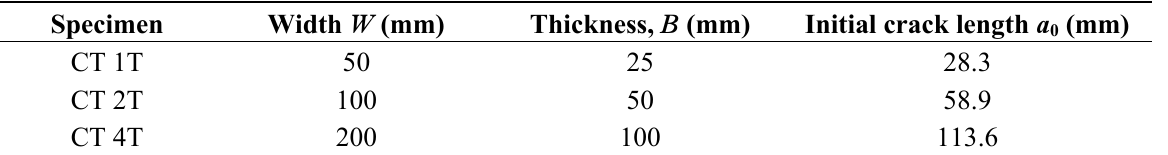
Table 1. Geometry of the compact tension test (CT) specimens of DIN 22NiMoCr37 steel